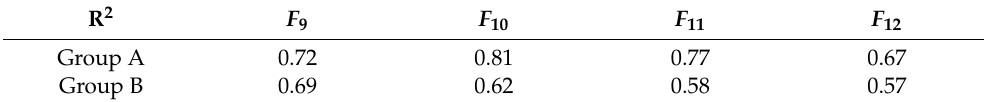
Table 4. Test results of the wind-vortex bulge degree and the bulge direction relation